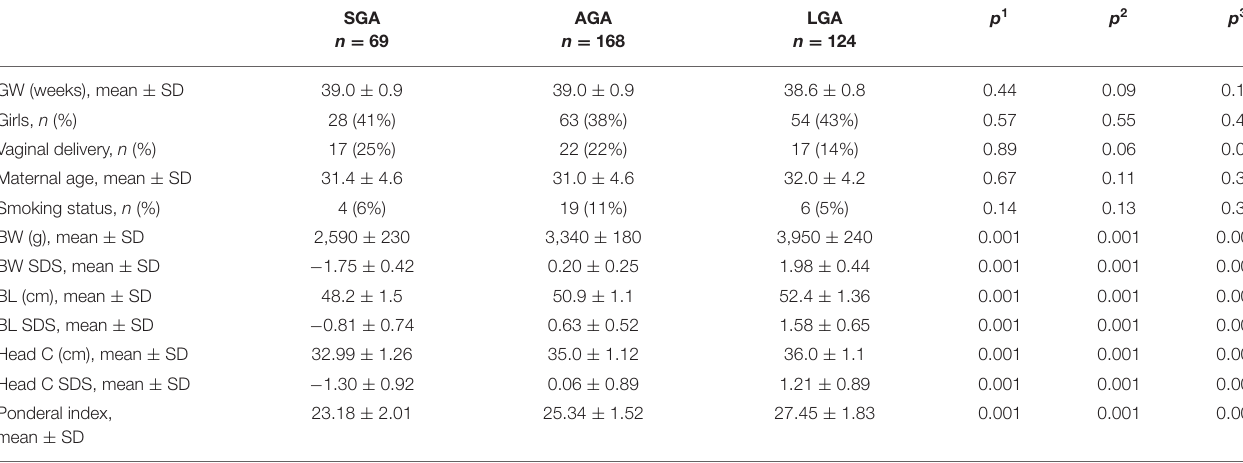
TABLE 1 | Demographic characteristics and birth anthropometry of the study population.